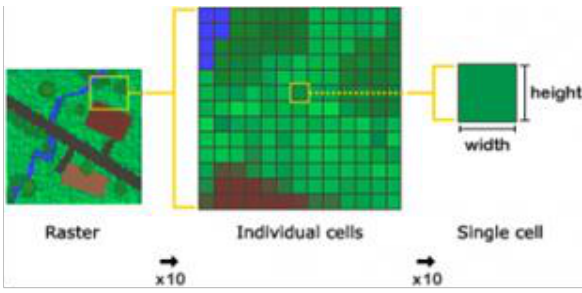
Figure 5. Pixel as the basic unit of Raster – discrete type (GICHD,